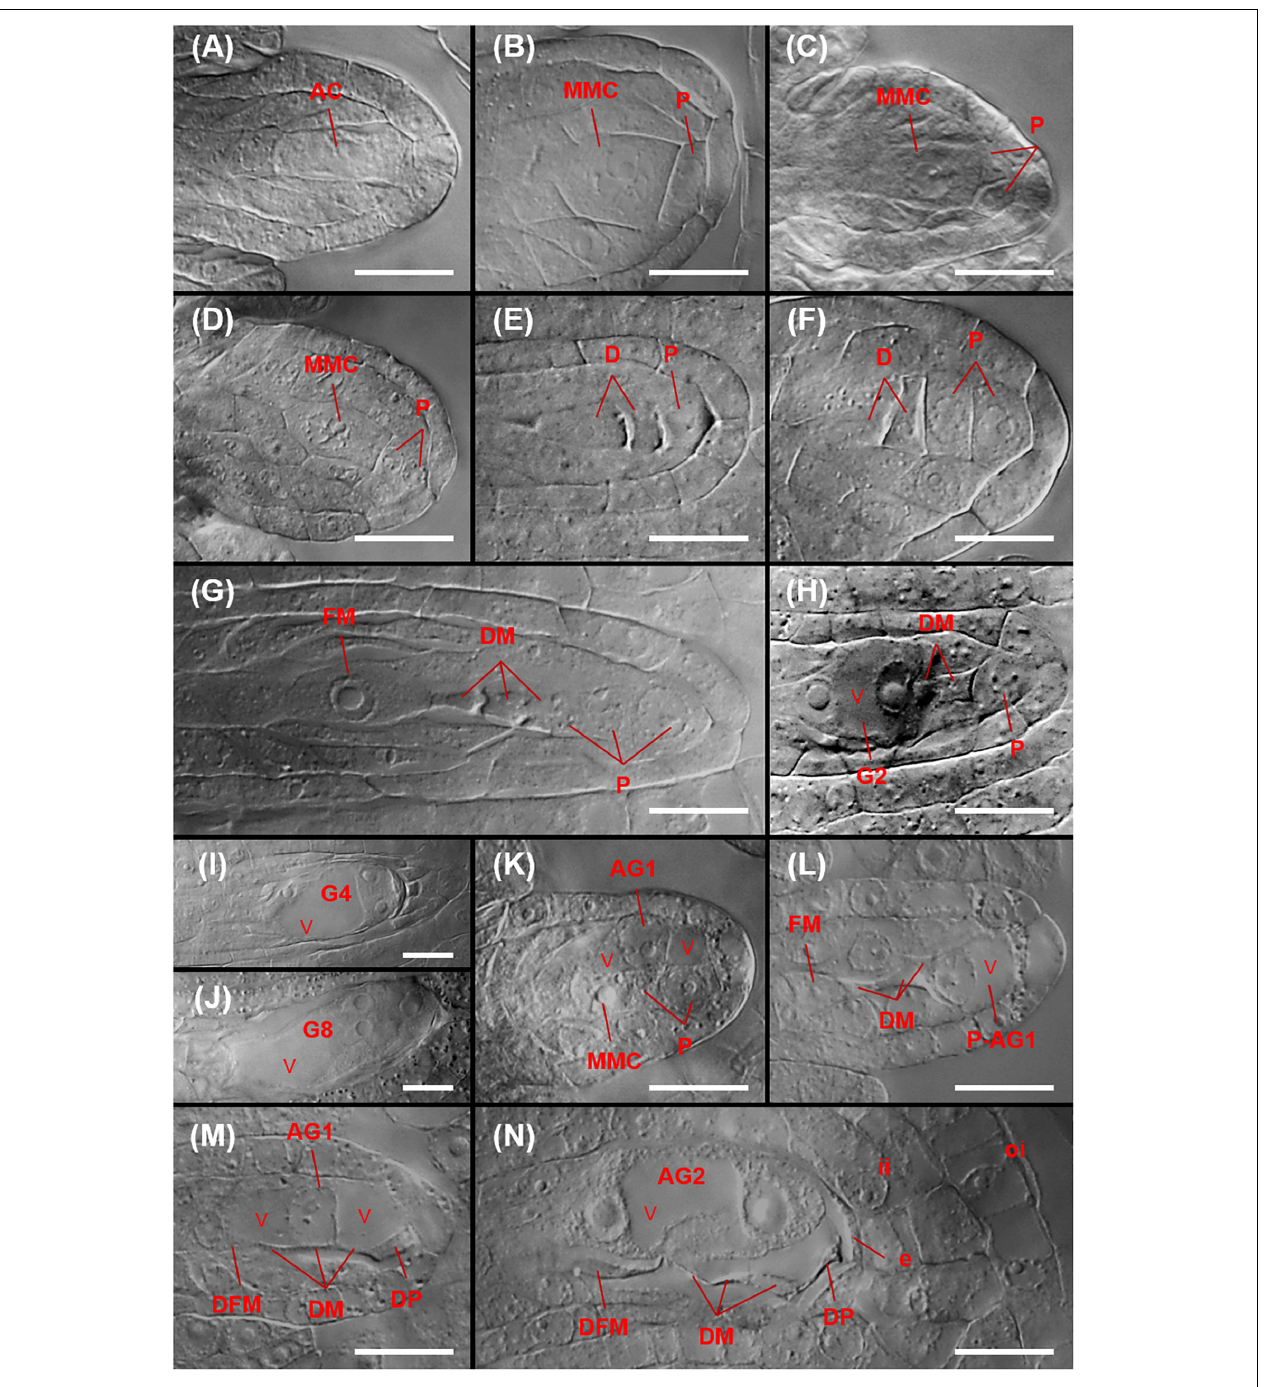
FIGURE 9 | Megasporogenesis and sexual and aposporous gametophyte formation in P. fremontii (A,K–N) and sexual C. douglasii (B,D,F,G) , N. holmgrenii (C) , and S. perplexa (E,H–J) . (A) Archesporial cell (AC) at the budding integument stage. (B) Mitotic division of an AC yielding a proximal MMC and a distal parietal cell (P). (C,D) Anticlinal and paraclinal divisions, respectively, of a P to yield a two-celled parietal tissue. (E,F) Dyads (D) with one and two Ps, respectively. (G) Tetrad showing the functional megaspore (FM) and three degenerating megaspores (DM). Also shown is a parietal tissue consisting of three Ps that formed from two paraclinal divisions of the original P. (H) Two-nucleate sexual gametophyte (G2) showing a central vacuole (v), two of three DM, and a P. (I) Four-nucleate sexual gametophyte (G4) with three nuclei visible. (J) Eight-nucleate sexual gametophyte (G8) showing egg apparatus formation at the micropylar end of the gametophyte. (K) 1-nucleate aposporous gametophyte (AG1) from a nucellar cell at the MMC stage. (L) AG1 from a parietal cell (P-AG1) at the tetrad stage. (M) AG1 from a nucellar cell at the late tetrad stage showing functional megaspore degeneration (DFM), DMs, degenerating nucellar cells, and a degenerating parietal cell (DP). (N) Two-nucleate aposporous gametophyte (AG2) at the late tetrad stage showing a DFM, DMs, degenerating nucellar cells, a degenerating parietal cell (DP), and degenerating epidermal cells. Scale bars, 20 µ m.